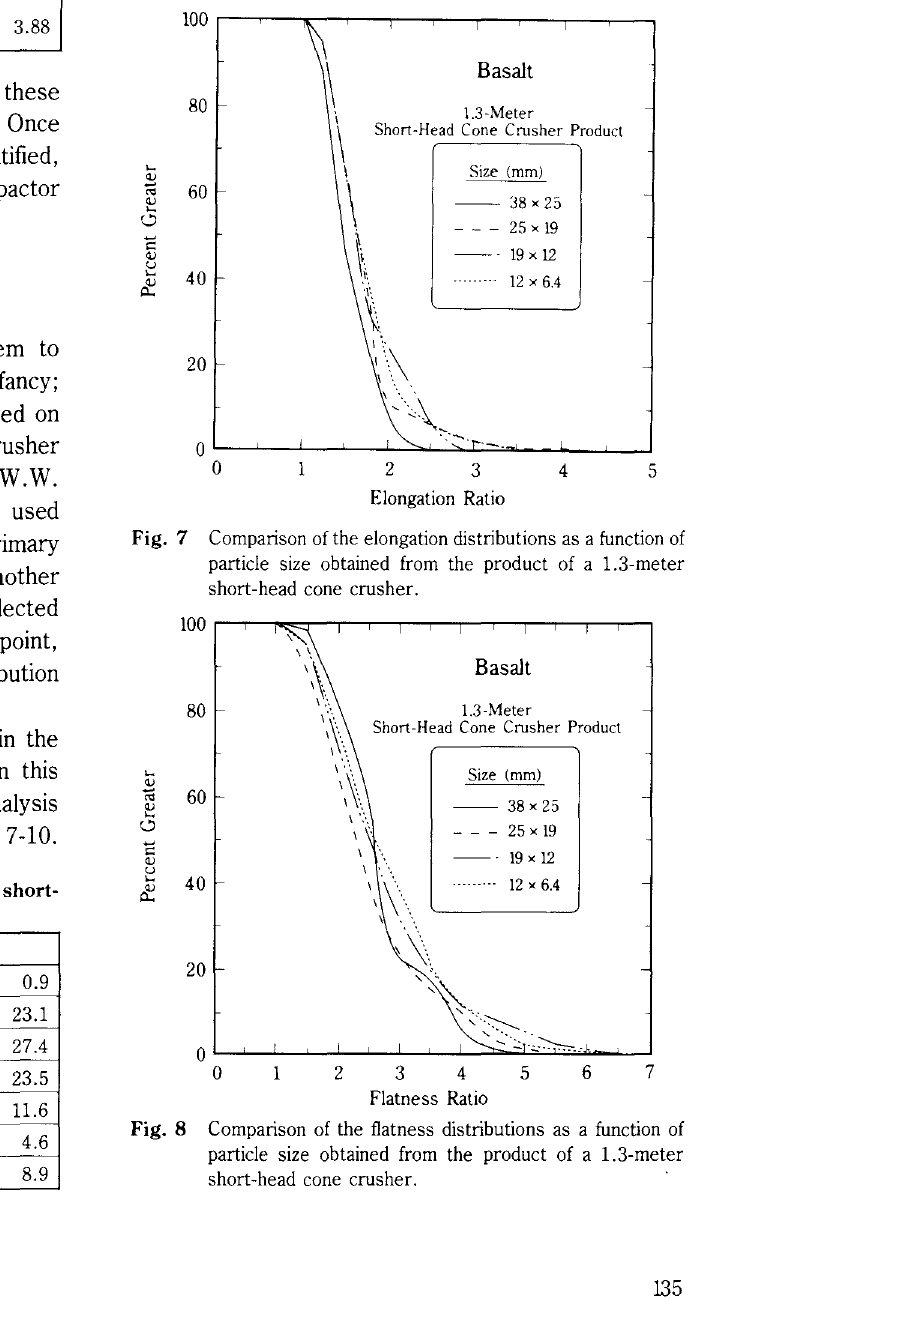
Fig. 8 Comparison of the flatness distributions as a function of particle size obtained from the product of a 1.3-meter short-head cone